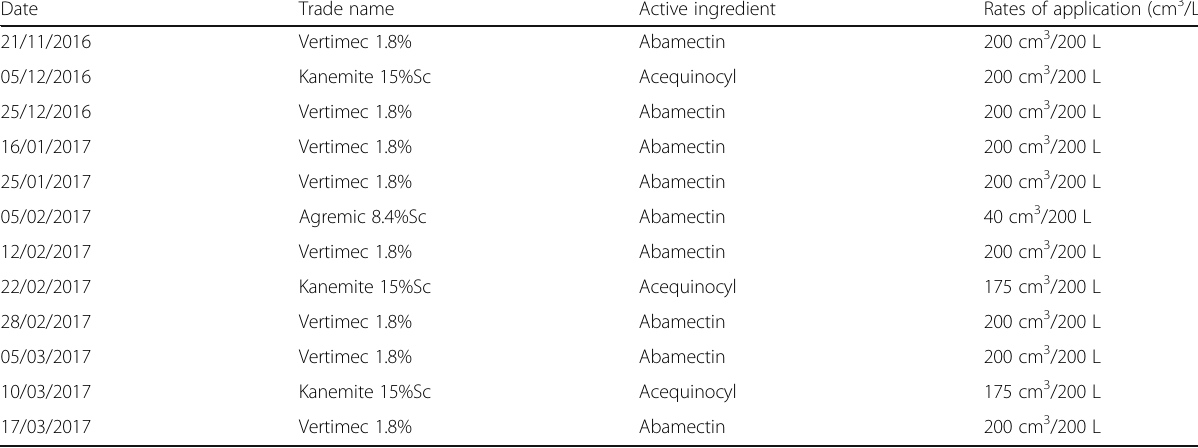
Table 1 A list of pesticide application used to control T. urticae on sweet pepper in greenhouse using a chemical treatment